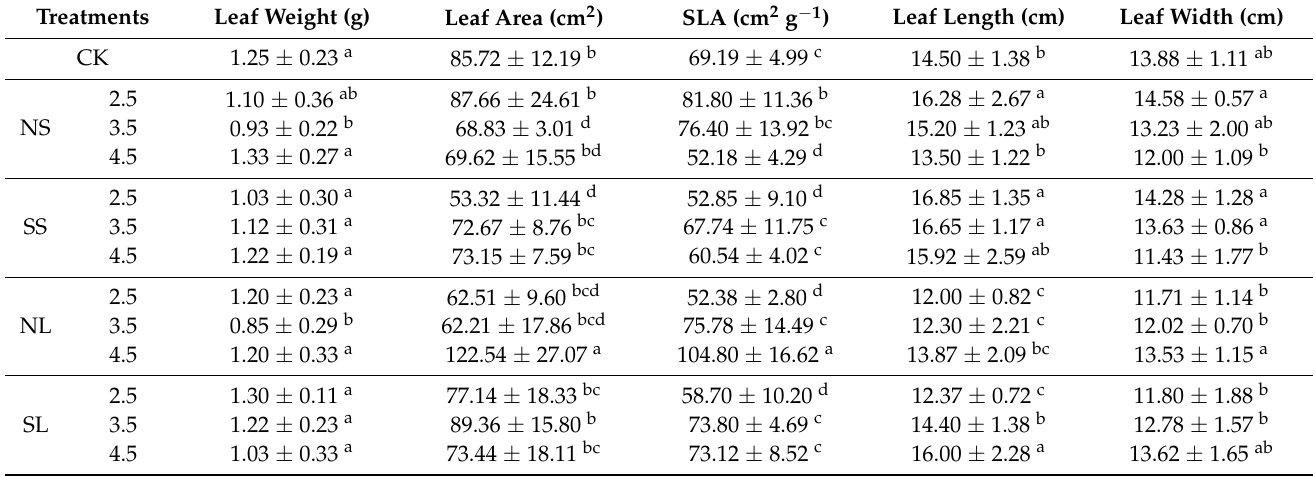
Figure 3. Effect of different forms of acid stress on the crown of A. catalpifolium during the 16-month observation period. The treatments: CK, NS ( A ), NL ( B ), SS ( C ) and SL ( D ) are defined as control, nitric-balanced acid applied to soil, nitric-balanced acid applied to leaves, sulfuric-dominated acid applied to soil and sulfuric-dominated acid applied to leaves, respectively. Values are the average ± standard deviation (n = 10). Table 1. Effect of different forms of acid stress on leaf weight and specific leaf area (SLA) of A. catalpifolium. The treat- ments: CK, NS, NL, SS and SL are defined as control, nitric-balanced acid applied to soil, nitric-balanced acid applied to leaves, sulfuric-dominated acid applied to soil and sulfuric-dominated acid applied to leaves, respectively. Values are the average ± standard deviation (n = 10). Different superscript letters in each column indicated a significant difference among different acid treatments ( p <